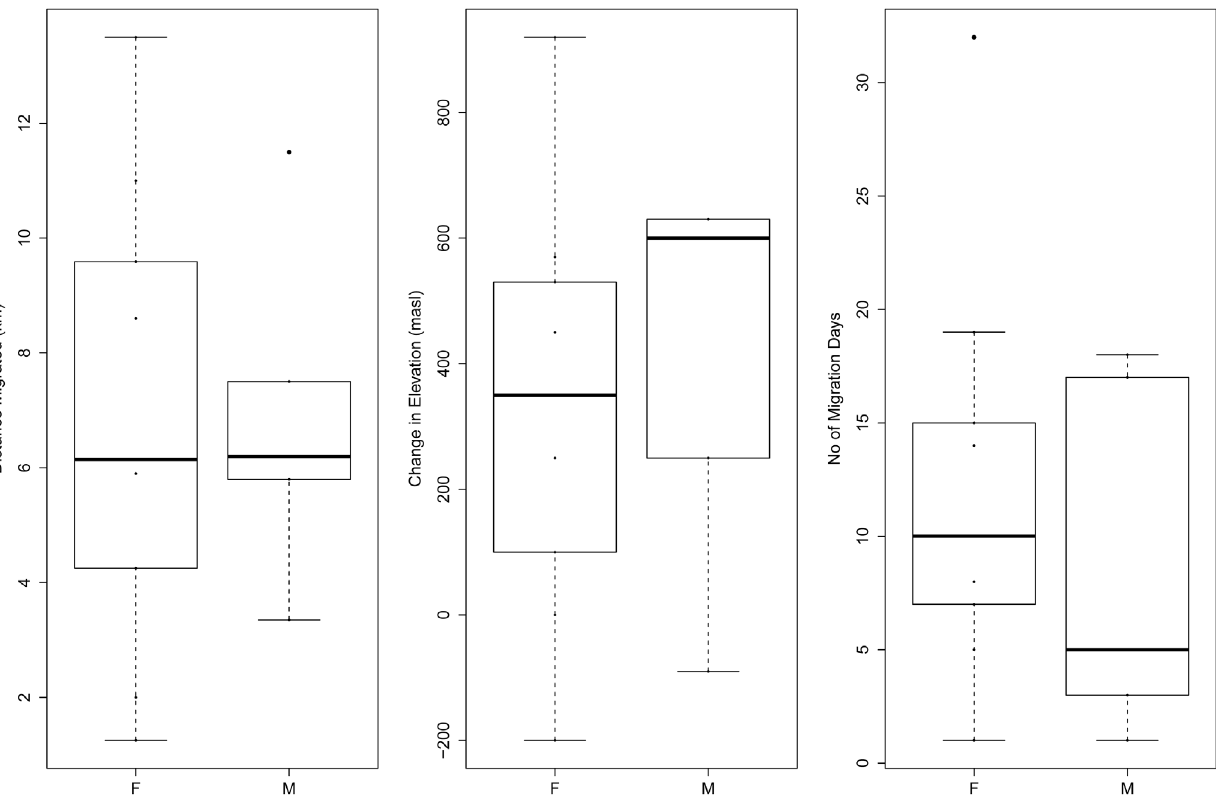
Figure 4. Boxplots for distance migrated (A), change in elevation (B) and duration of migration (C) by sex (n=24, females =11 and males =13).